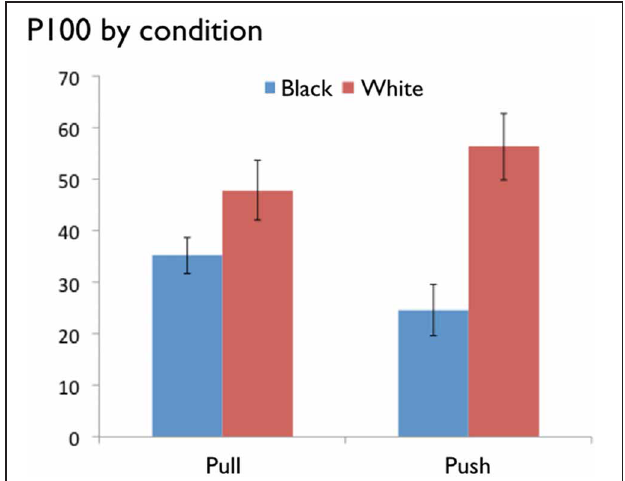
FIGURE 3 | Mean amplitudes for the P100 for Black and White faces in the Pull and Push